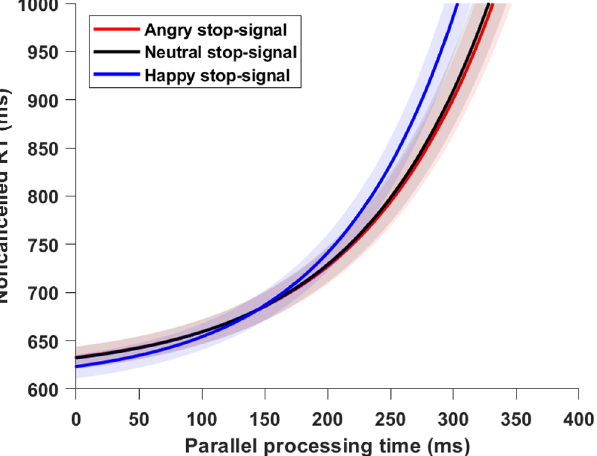
Figure 4. Noncancelled RT fitted with PPT. We fitted noncancelled RT and PPT data with an exponential function (noncancelled RT = εe b(PPT) + c ). We fixed ε at 17 ms (equal to one refresh duration of the display monitor). Coefficients ‘b’ and ‘c’ were fitting coefficients that varied across participants. The average (± SEM) of best fit across participants in three conditions is plotted as a function of PPT. The angry stop signal had the lowest attenuation